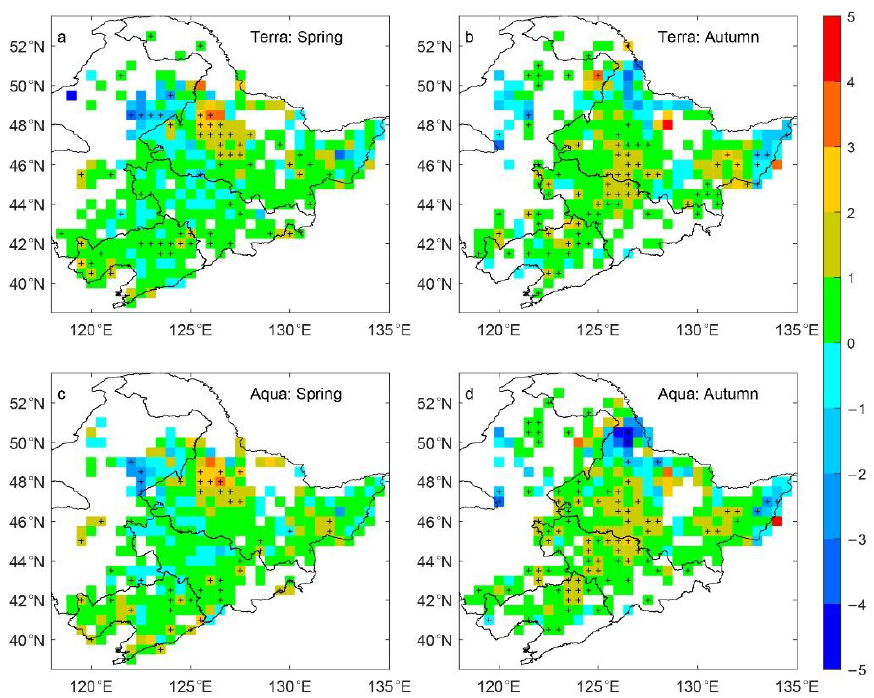
Figure 7. Long-term variation in mean fire radiative power for each fire spot (unit: MW/spot per year) during 2003–2018 in ( a , c ) spring and ( b , d ) autumn from Terra and Aqua fire products. The “+” sign indicates that the trend passed the significance test at the 5% level.